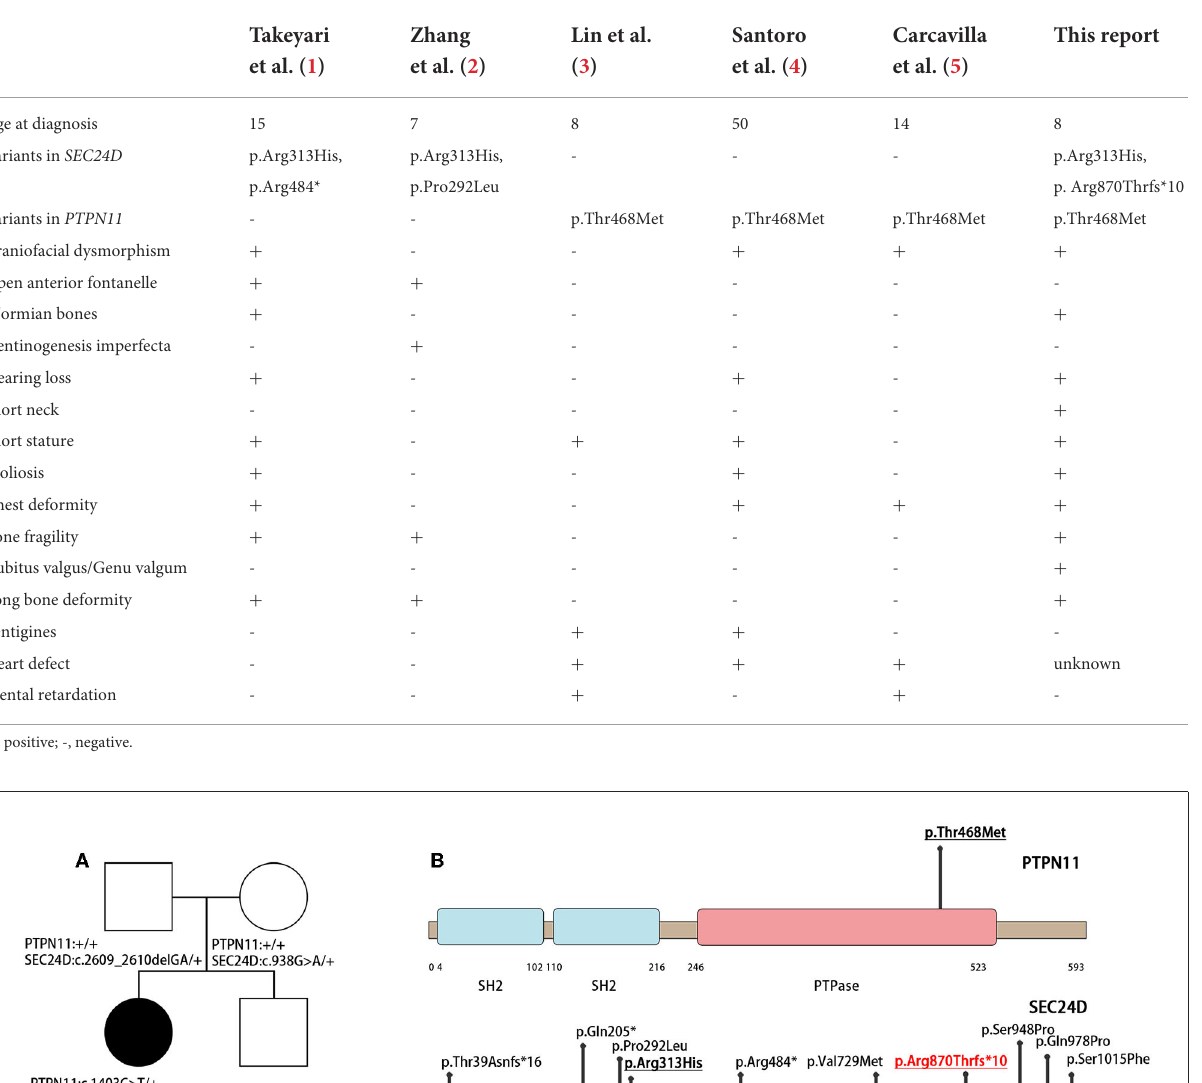
in this patient could have aggravated the manifestations of bone malformations and low bone mass in the spine, thorax, and pelvis. Repeated fractures also confirm that the SEC24D mutation had a significant impact on osteogenesis and bone